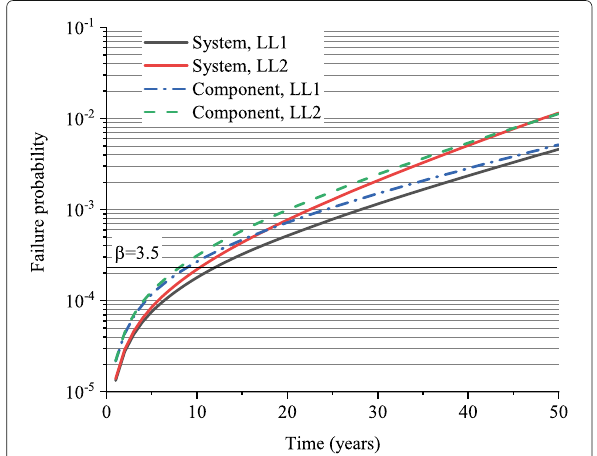
mean value and standard deviation of M ( R , 4 ) are smaller than those of the component resistance, and these two factors have opposite effects on the system reliability. In Fig. 3, the probability of failure of a series system is greater